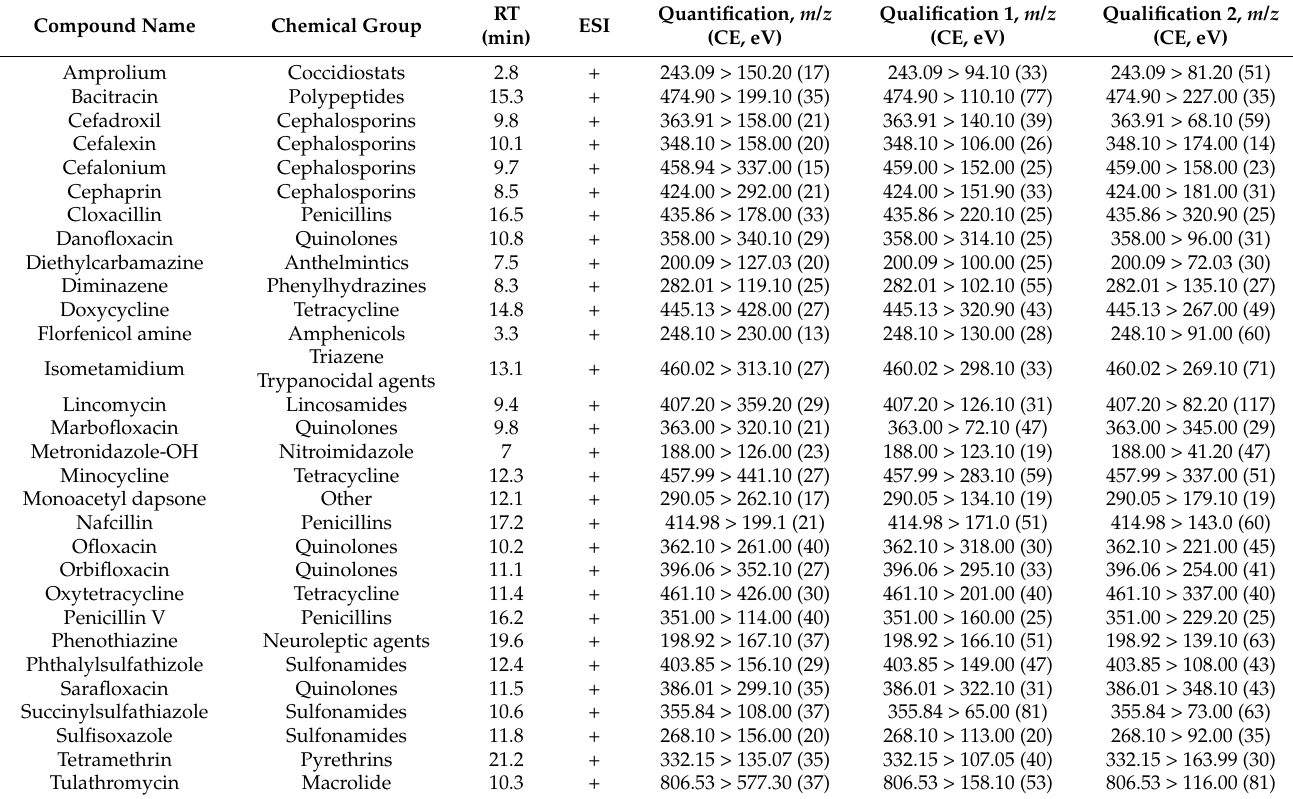
Figure 5. Analytical flow of the optimized method for the analysis of veterinary drugs in feed samples. Table 2. Retention time (RT) and MS/MS conditions for each